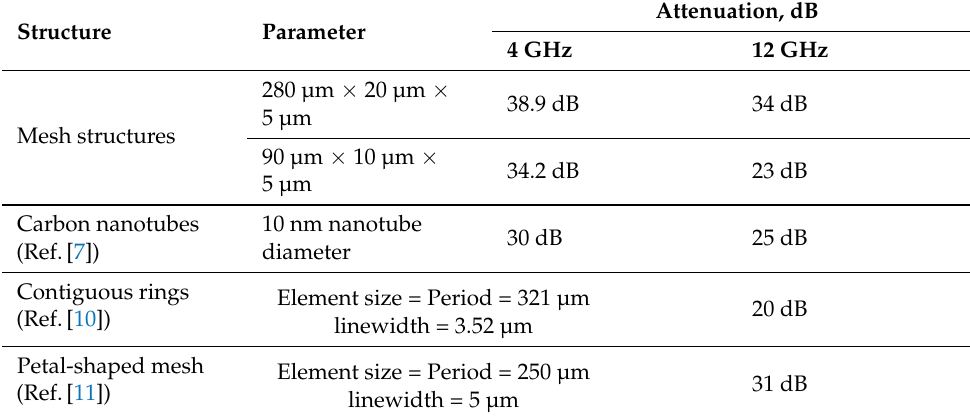
Table 1. Comparison of shielding surface attenuations at frequencies of 4 and 12